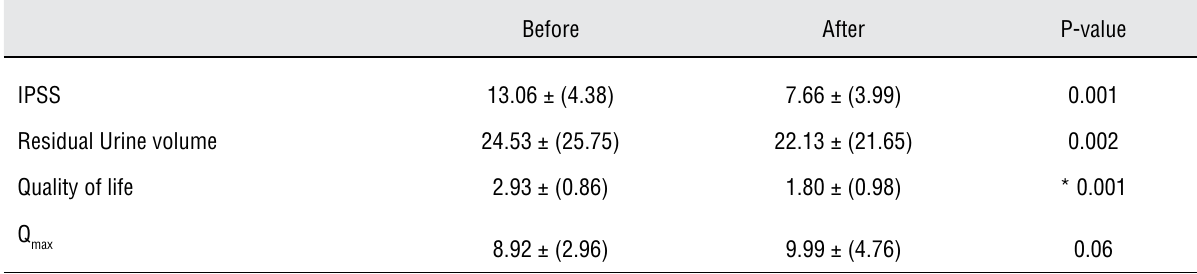
Table 3 - Mean values of variables before and after treatment of the drug group.